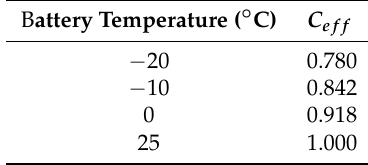
Table 3. Effective capacity factor ( C ef f ) of the battery as a function of temperature for a 0.1 C discharge. Data provided by Tripathy et al.